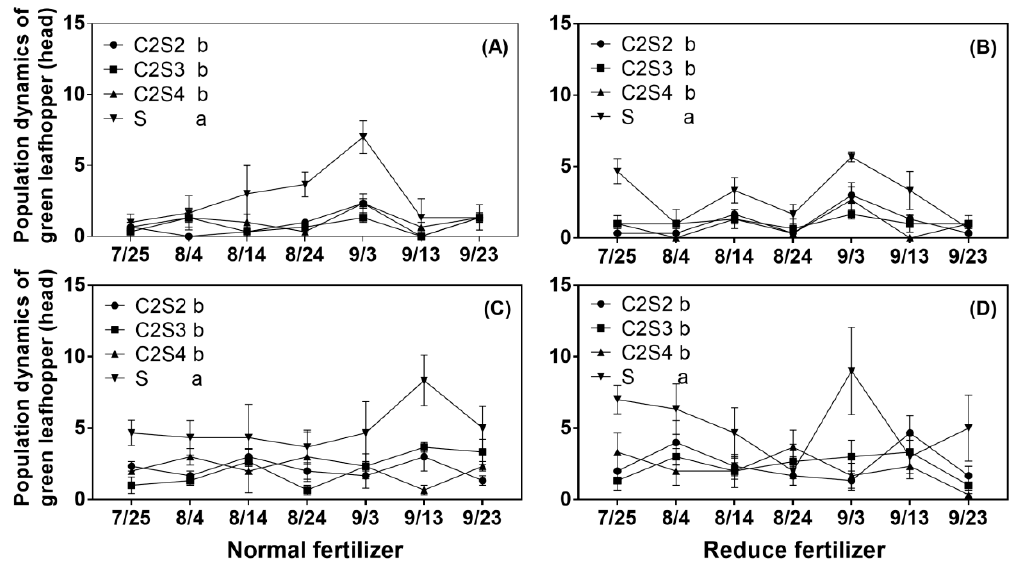
Figure 4. Population dynamics of green leafhoppers on soybean plants in 2018 ( A , B ) and 2019 ( C , D ) (Note: lowercase letters represent significant differences among different intercropping planting patterns by LSD test at p < 0.05).